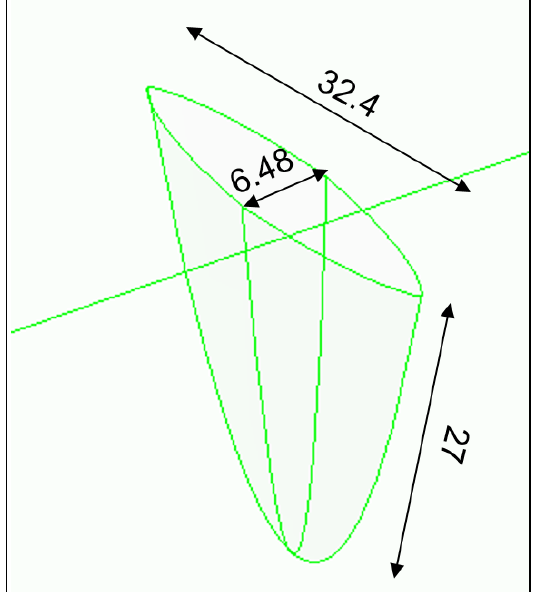
Figure 2. Model geometry.